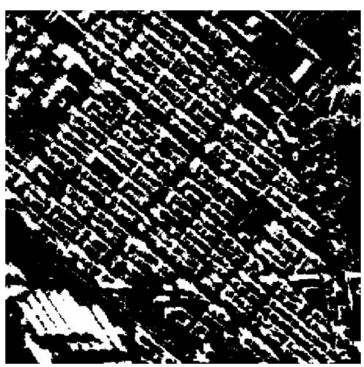
Figure 7. Sham Shui Po - shadow extraction result Shadows extracted in Sham Shui Po district are mainly formed